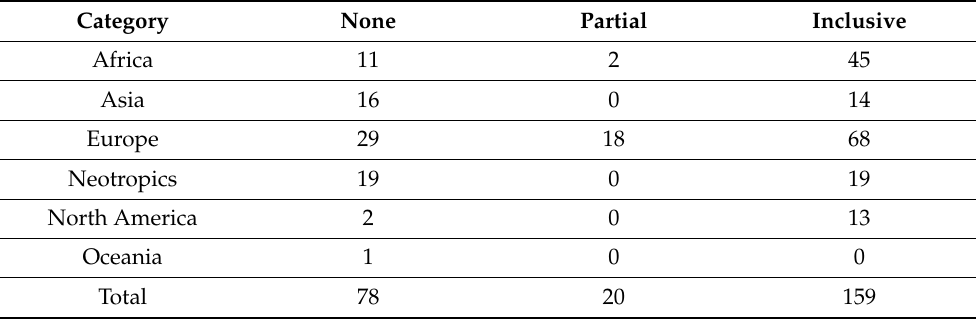
Table 5. Regional distribution of transboundary wetlands by RBO status. None indicates no RBO; Partial indicates an RBO that not all countries riparian to the wetland are members of; Inclusive indicates the presence of an RBO to which all countries riparian to the wetland are members of. None